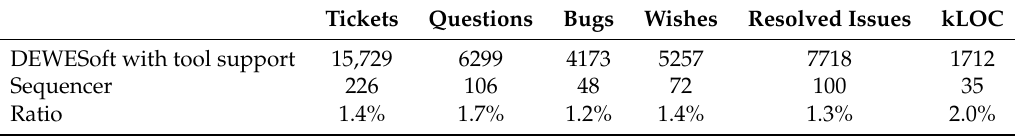
Table 4. Comparing maintenance effort between DSML and rest of the system. Tickets Questions Bugs Wishes Resolved Issues